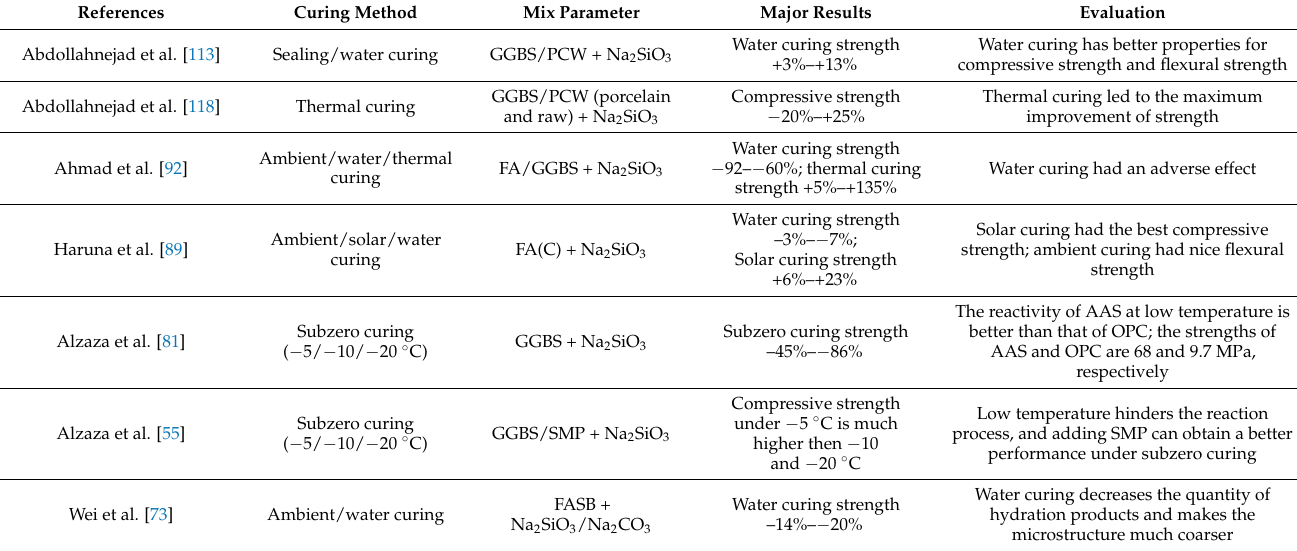
Table 4. Comparison of different curing methods on one-part